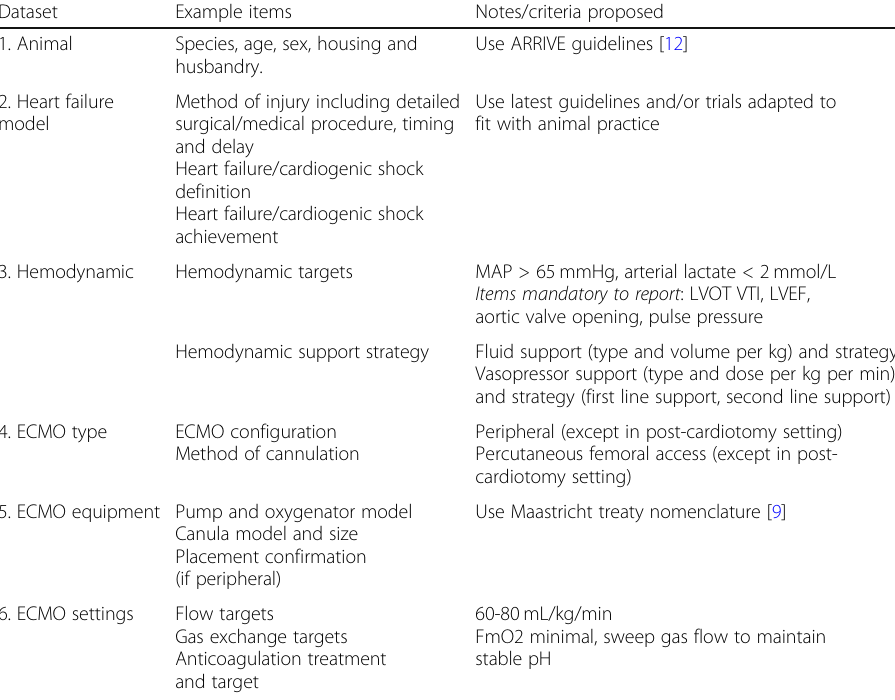
Table 5 Proposed minimum reporting dataset for pre-clinical models of heart failure supported by VA-ECMO Dataset Example